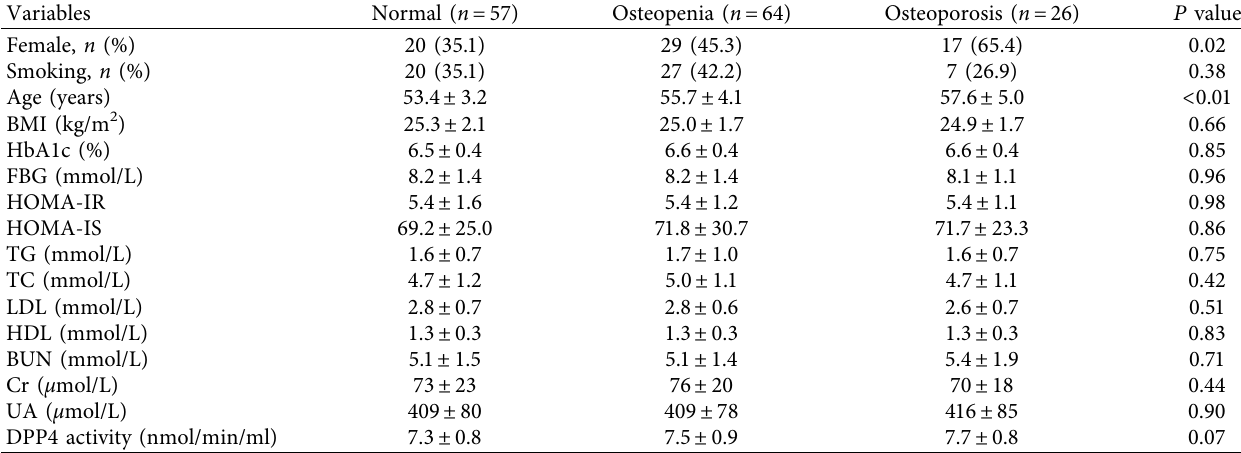
Table 1: Comparison of baseline characteristics by bone status across cohorts with newly diagnosed type 2 diabetes. Variables